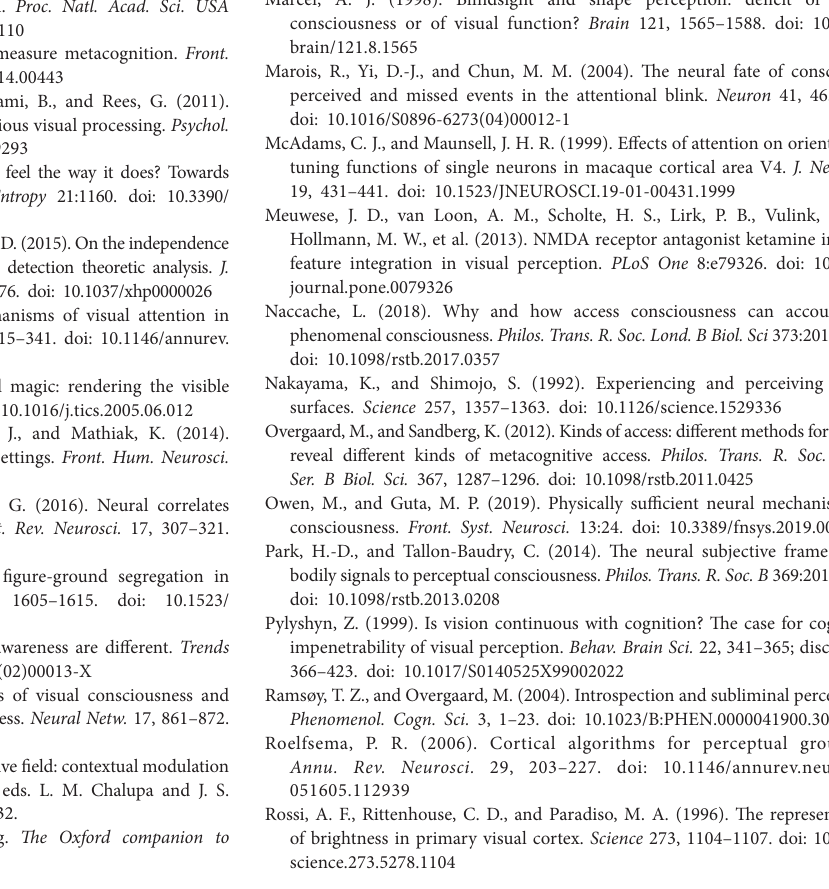
figure-ground signals in V1. J. Vis. 1:32. doi: 10.1162/089892902320474490 Landman, R., Spekreijse, H., and Lamme, V. A. (2003). Set size effects in